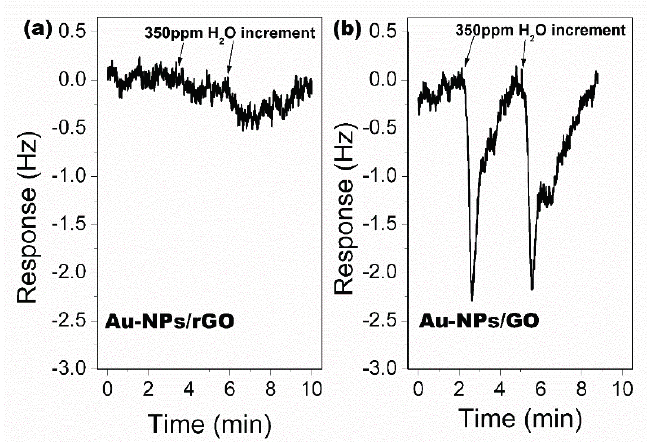
Figure 27. Sensing responses of the sensors loaded with Au-NPs/rGO ( a ) and Au-NPs/GO ( b ) to 350 ppm water. Reprinted with permission from